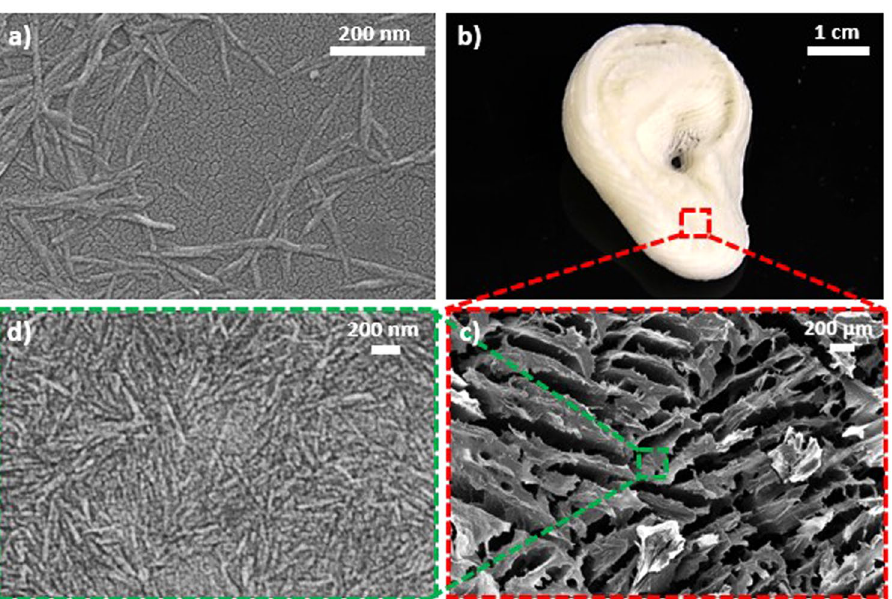
Figure 3. ( a ) SEM images of CNCs used during hydrogel generation for DIW processing. ( b ) After DIW 3D printing followed by freeze drying, an ear model without needing support material was successfully fabricated using 20 wt% CNC gel and 500 µ m nozzle tip. ( c ) Macroporous structure of the aerogel was confirmed by SEM analysis. ( d ) CNC, in a highly closed packed manner, that constituted the aerogel structure are also